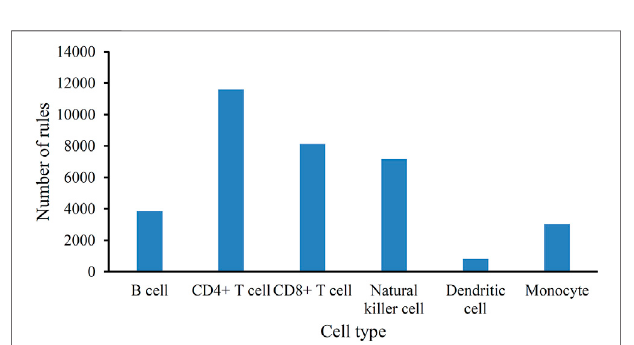
FIGURE 5 | Histogram of the number of classi fi cation rules corresponding to the four categories (disease status) in the six immune cell